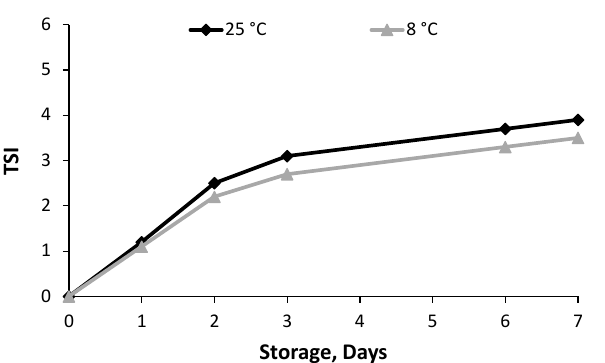
Figure 3. Global physical stability of the fish oil-in-water-in-olive oil double emulsion at two different storage temperature values (8 and 25 °C) given by TSI (Turbiscan Stability Index).